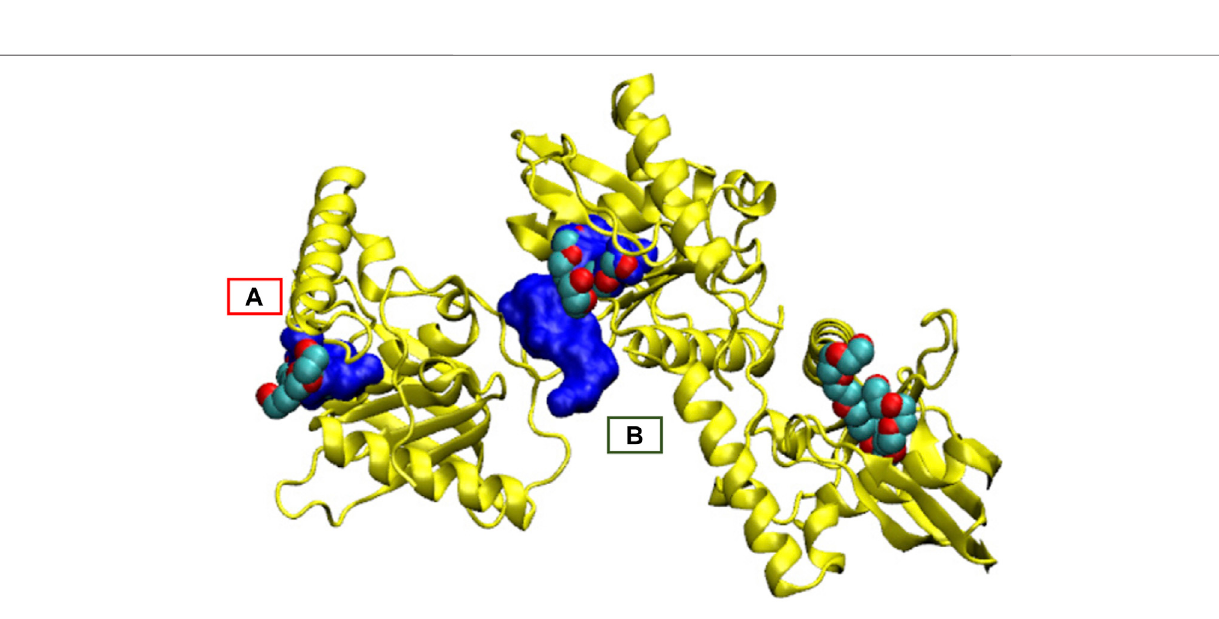
FIGURE 8 | Main pocket shift for 1icj together with the co-crystallized ligand. (A) Main pocket detected when adding hydrogen atoms. (B) Main pocket without addinghydrogenatoms.Thepocketissemanticallythesameorthostericpocketbutchangesfromonemonomertoanother.Thethreestructuresofligandsboundinthe PDB structure are also